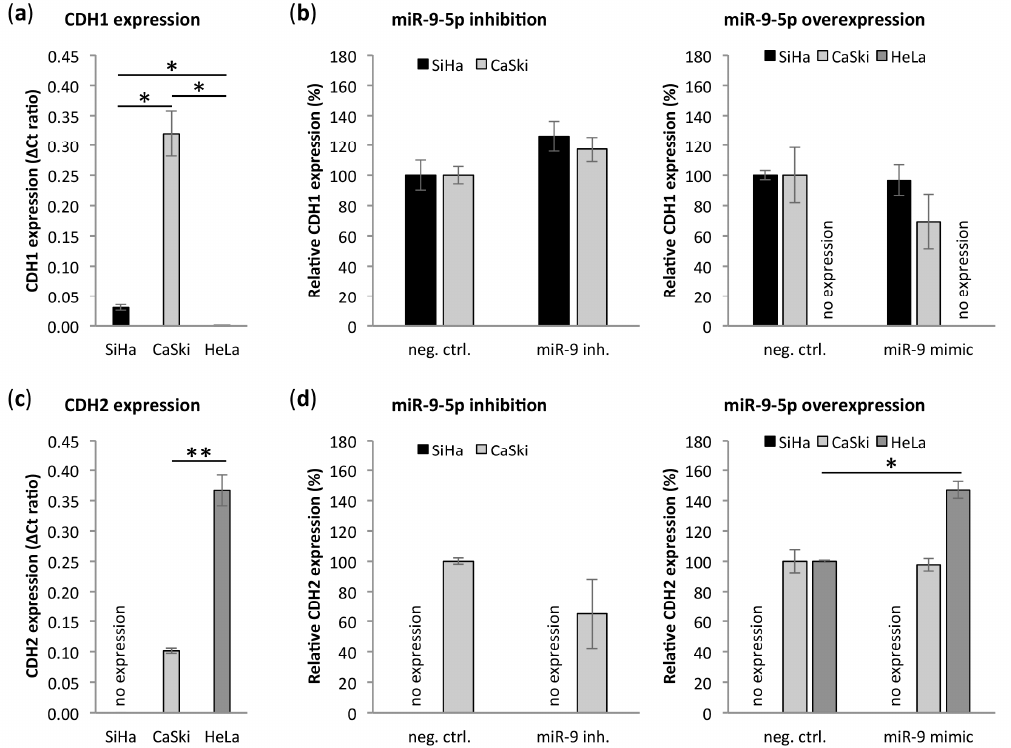
Figure 5. Effect of miR-9-5p on E-cadherin (CDH1) and N-cadherin (CDH2). Endogenous expression of ( a ) CDH1 and ( c ) CDH2 mRNA in cervical cancer cell lines SiHa, CaSki and HeLa. Expression of ( b ) CDH1 and ( d ) CDH2 upon inhibition and overexpression of miR-9-5p relative to the respective negative control. CDH1 expression remained undetected in HeLa after transfection and CDH2 expression remained undetected in SiHa. * p < 0.05, ** p <